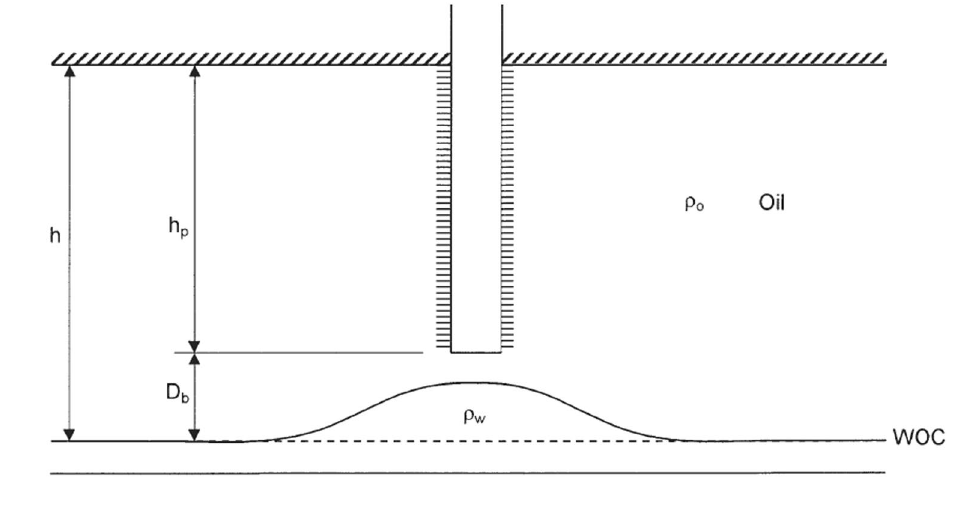
Fig. 2 Perforation spacing